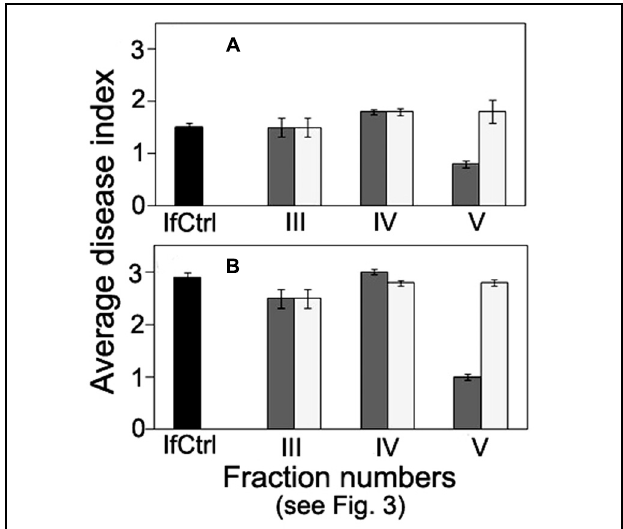
FIGURE 5 | Comparison of anti-wilt activity of the fractions obtained by exclusion chromatography of high-molecular weight metabolites from F. oxysporum strain CS-20. Seedlings were inoculated by immersion in a suspension with a final concentration of 10 6 spores/ml, containing spores of two pathogenic strains F37 and Fot3 (1:1). Disease symptoms were examined at 15 (A) , and 21 (B) days after inoculation of tomato seedlings, which roots were pre-exposed to intact (dark gray columns) or proteinase K-treated (light gray columns) fractions eluted as peaks III, IV, and V. Inoculated seedlings non-exposed to the fractions are referred to as infected control (IfCtrl, black columns). Histograms represent values of average disease index from two independent experiments of each treatment done in triplicate. Bars represent